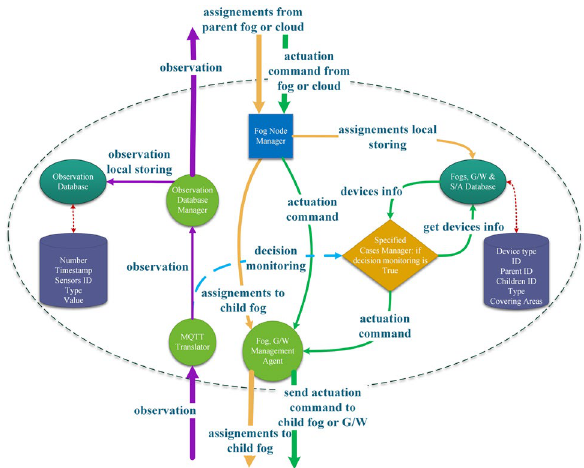
Figure 4. Fog node design with all its components and types of internal messages among its